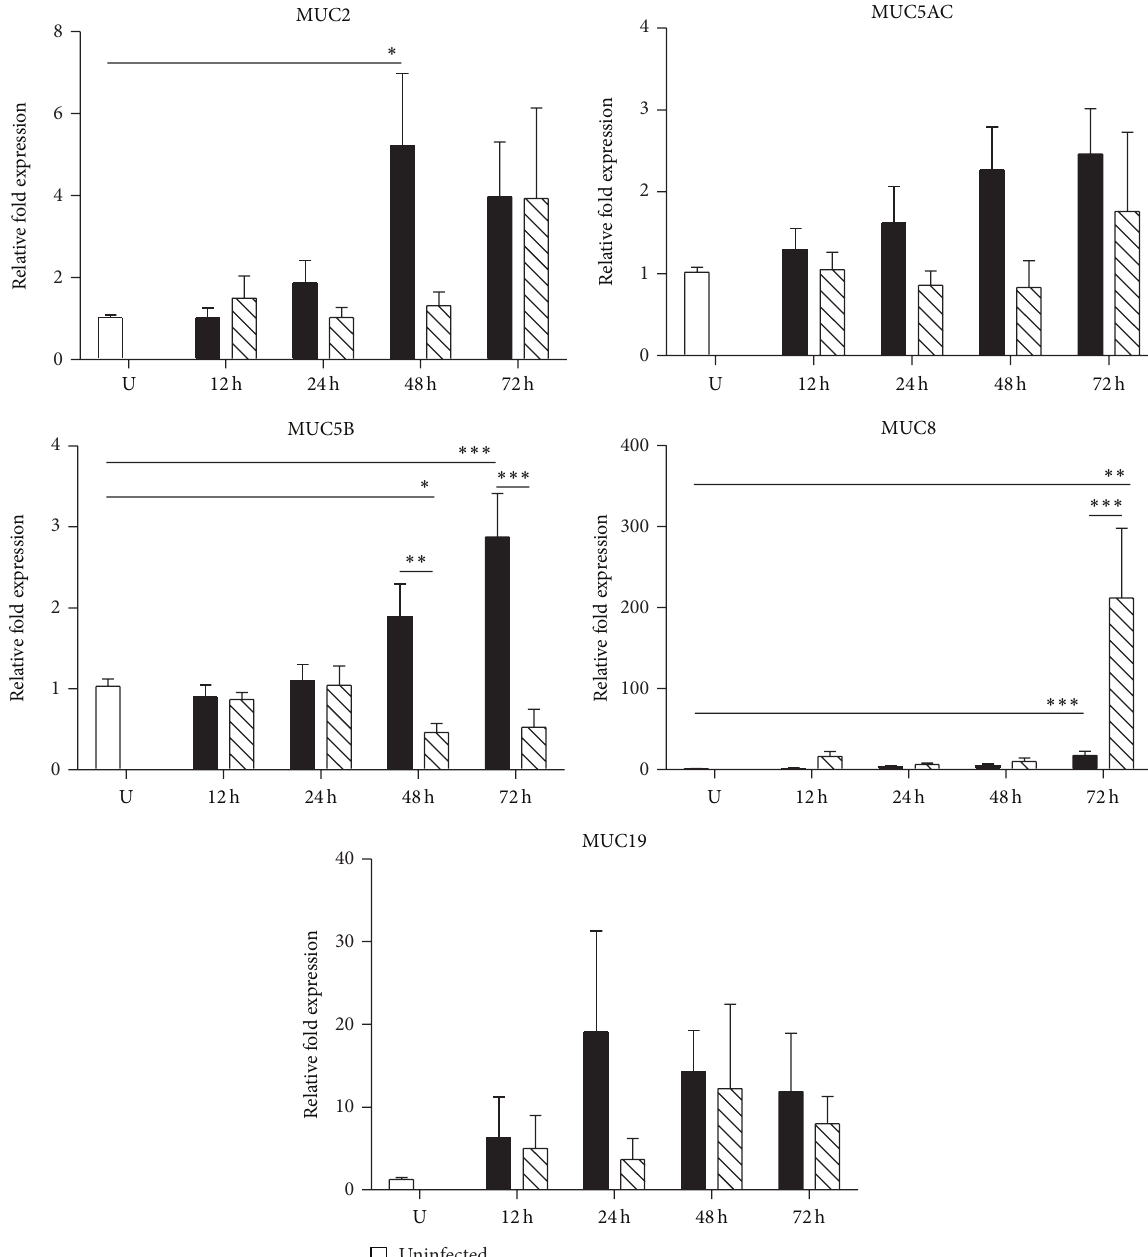
Figure 1: Secreted mucins expression in A549 by hMPV and RSV infection. Cells were infected with hMPV or RSV at an MOI of 3 for 12, 24, 48, or 72 h. RNA was isolated, and the expression of MUC genes was determined by qRT-PCR. Data shown in the graphs are the mean of 5 independent experiments. Statistical significant differences are indicated. ∗ 𝑃 < 0.05 ; ∗∗ 𝑃 < 0.01 ; ∗∗∗ 𝑃 < 0.001